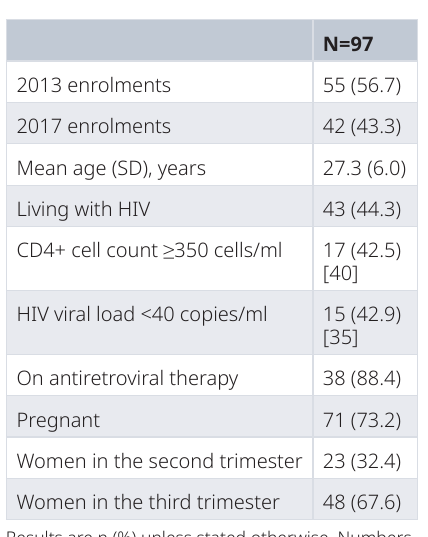
Table 1. Characteristics of the South African women participating in the